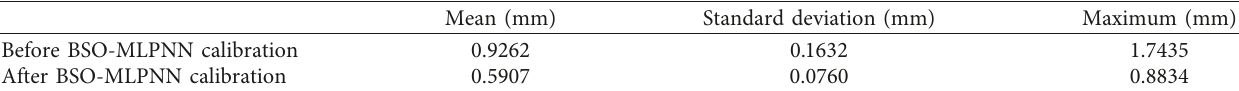
Table 8: Absolute positioning accuracy of the SIASUN SR210D manipulator of measurement